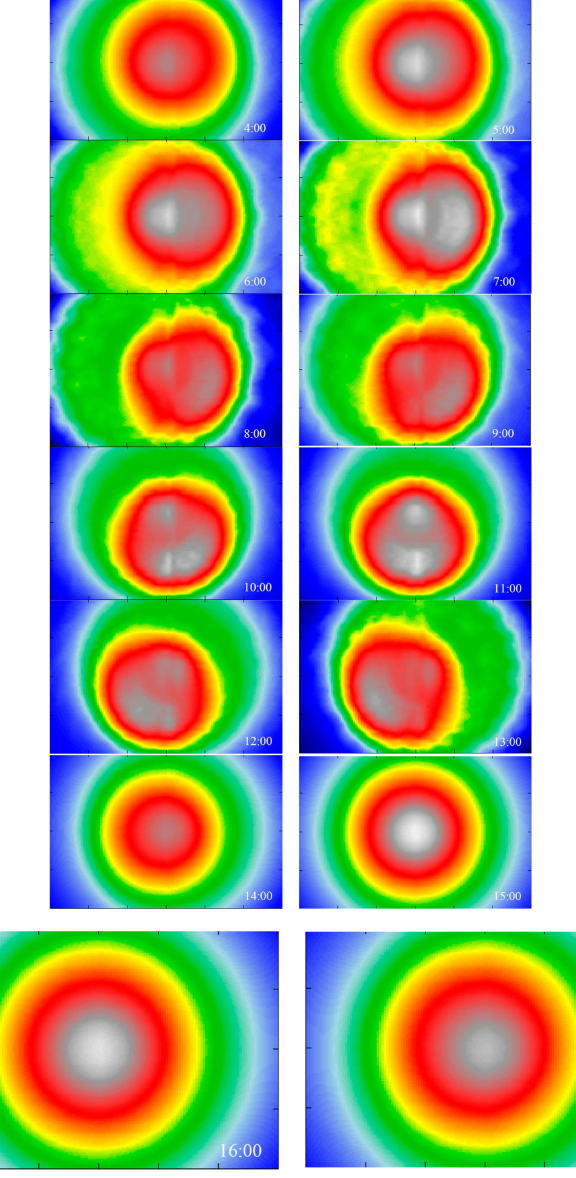
Figure 14. The same as in Figure 13, but for Perez’s all-weather